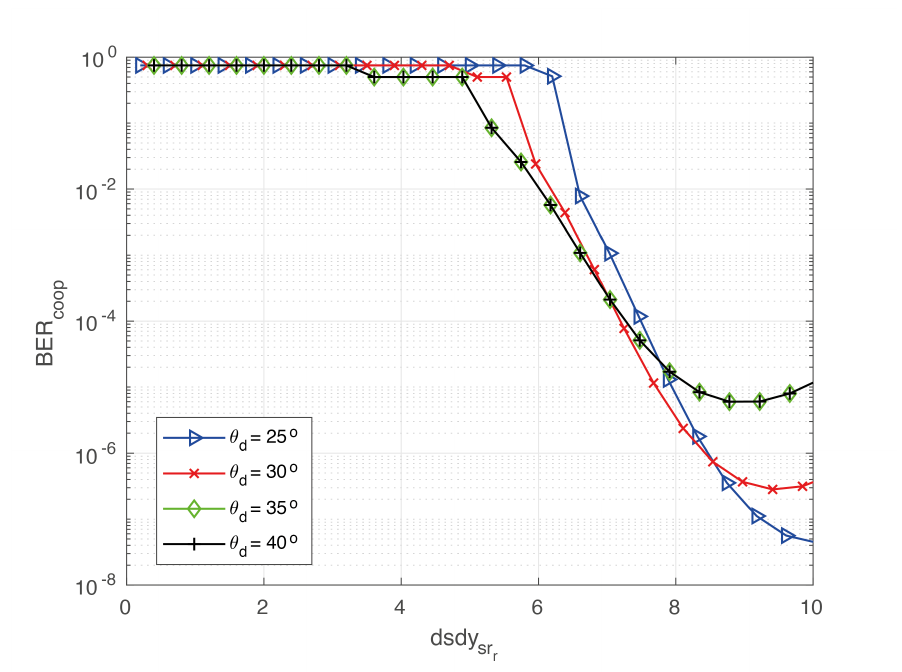
Figure 9. Cooperative BER as a function of dsdy sr